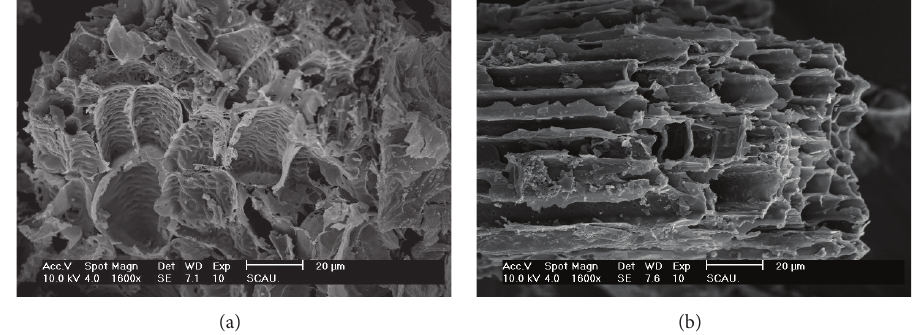
Figure 1: Scanning electron microscope images of two biochar used in this study. (a) Biochar made by peanut shell; (b) biochar made by wheat